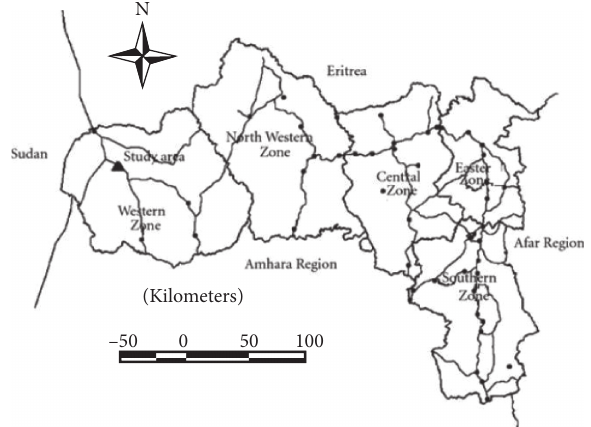
Figure 1: Map of Tigrai regional state showing the study area